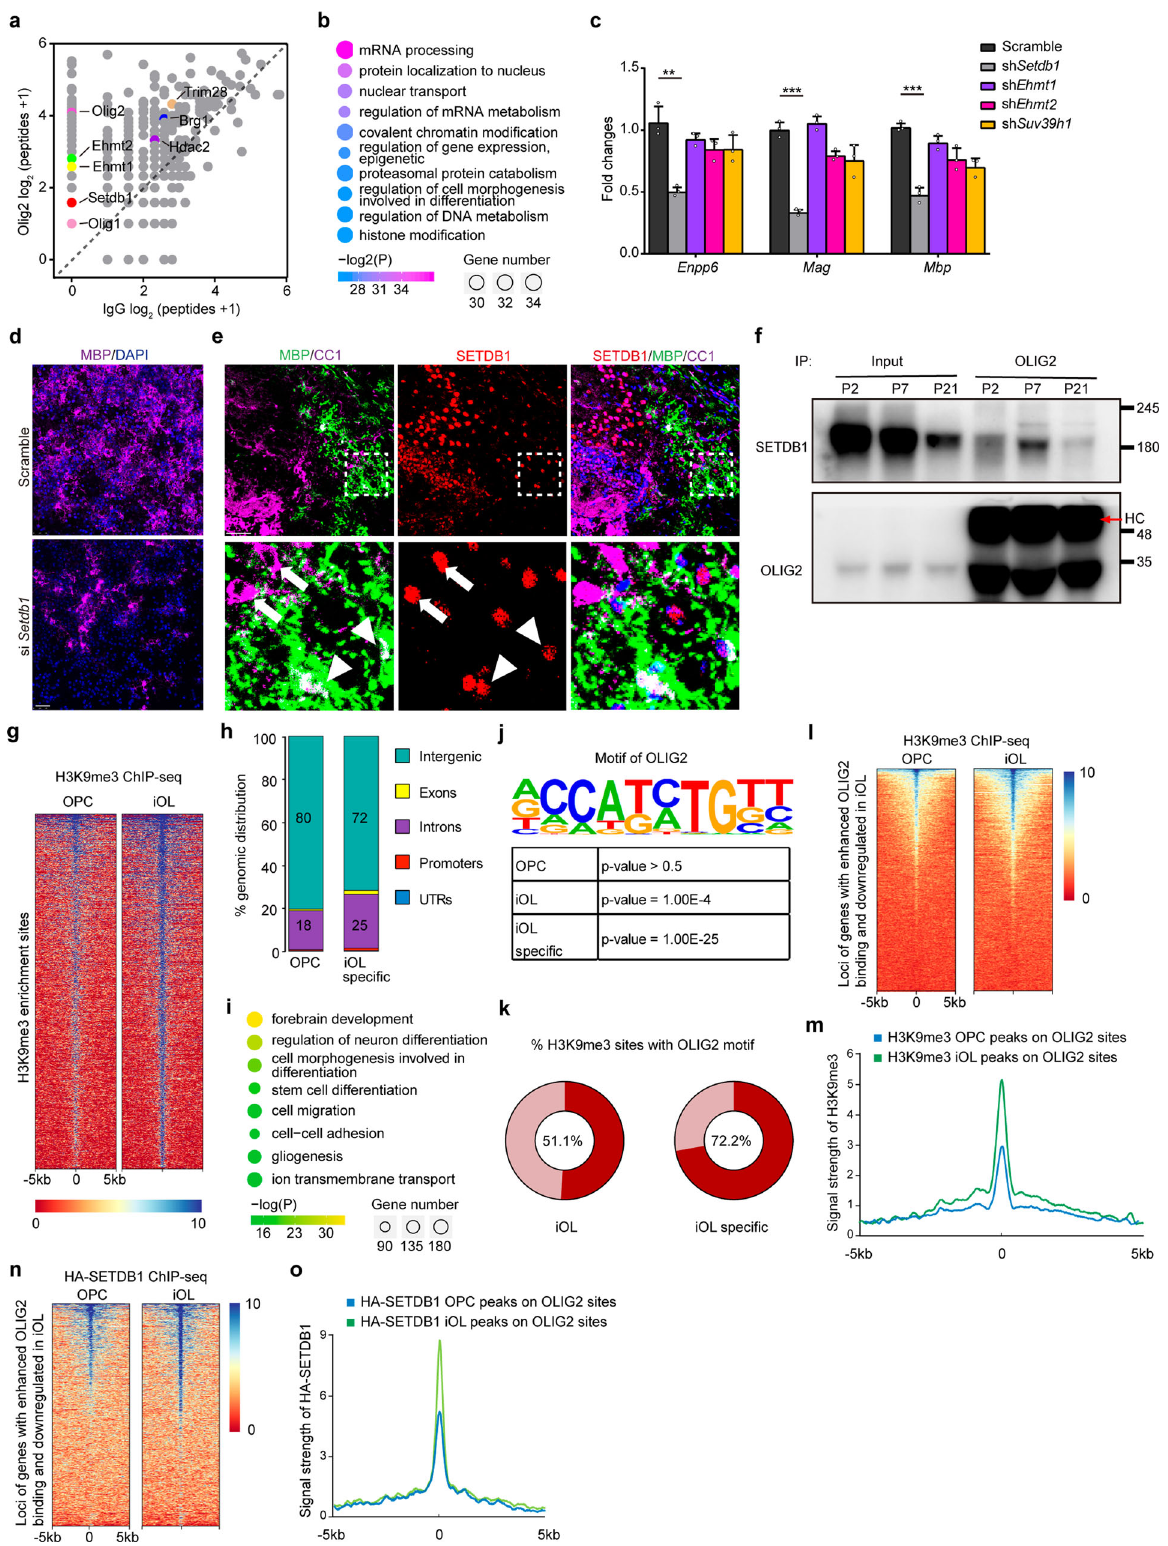
up in OPCs, contained OLIG2 motif, while the ratio reduced to 51.1% when we considered whole H3K9me3-enrichment regions in iOLs (Fig. 2k). Furthermore, in rat iOLs the enrichment of H3K9me3 was strengthened in loci of genes which are down- regulated and have enhanced OLIG2 binding upon differentiation (Fig. 2l, m). The occupancy of SETDB1 along genome